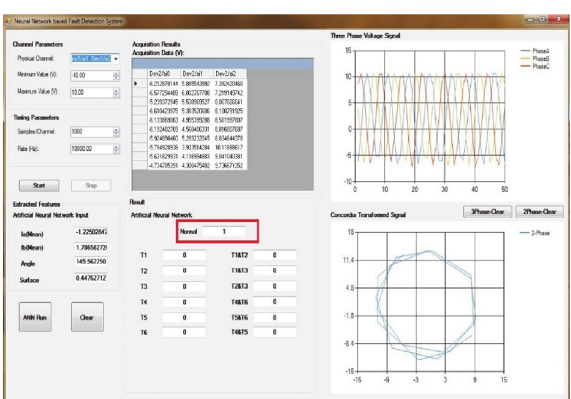
Figure 16: Artificial neural network based fault detection and diagnosis system. Figure 17: System operating in normal condition.